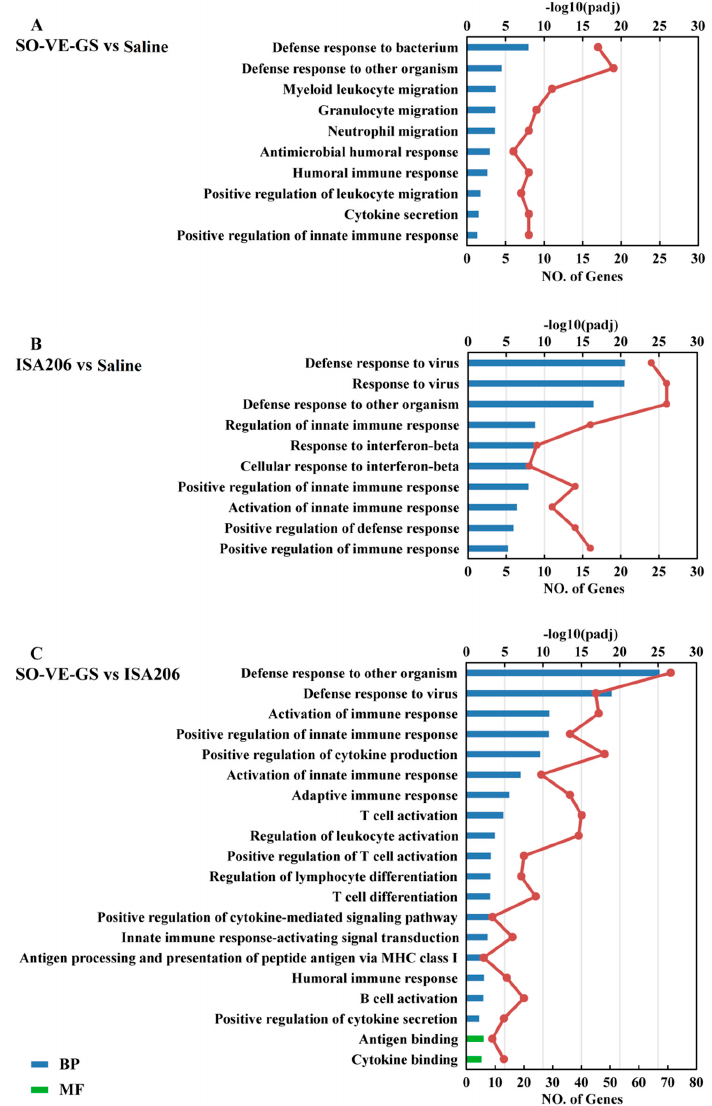
Figure 8. GO functional enrichment analysis. The GO terms related to immune responses were classified based on Gene Ontology. DEGs of ( A ) SO-VE-GS vs Saline, ( B ) ISA206 vs Saline, and ( C ) SO-VE-GS vs ISA206 were used for GO functional enrichment analysis. GO terms with a corrected P value less than 0.05 were considered significantly enriched by differentially expressed genes.